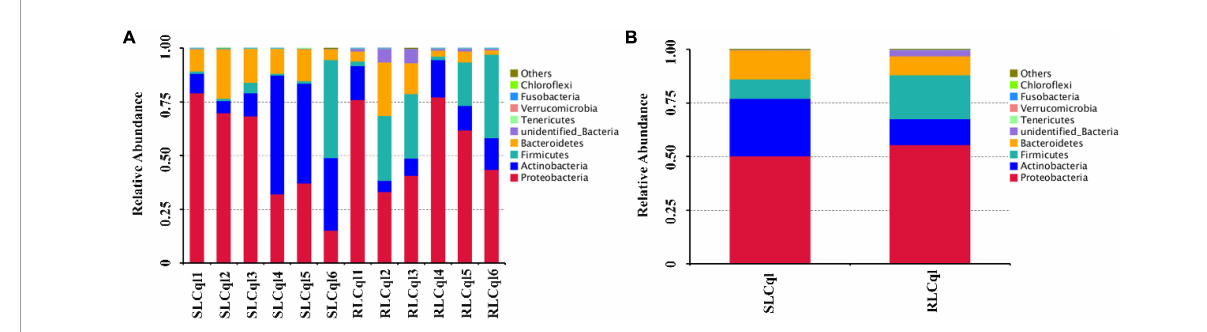
FIGURE2 Symbiotic gut bacterial composition at the phylum level in strains that are susceptible and resistant to Lysinibacillus sphaericus C 3 -41. (A) The taxonomic composition of the dominant phyla per replicate of susceptible and resistant strains of Cx. quinquefasciatus , (B) the average taxonomic composition of the dominant phylum of the susceptible and resistant strains of Cx. quinquefasciatus